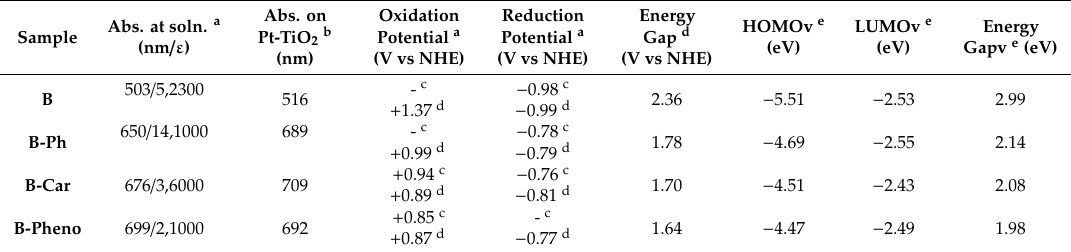
Table 1. Physical / theoretical properties of B, B-Ph , B-Car , and B-Pheno